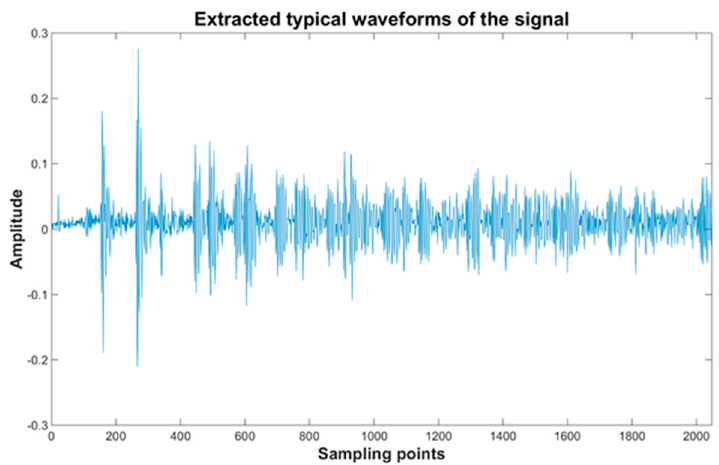
Figure 5. Typical waveforms of the signal measured in the intact specimen.